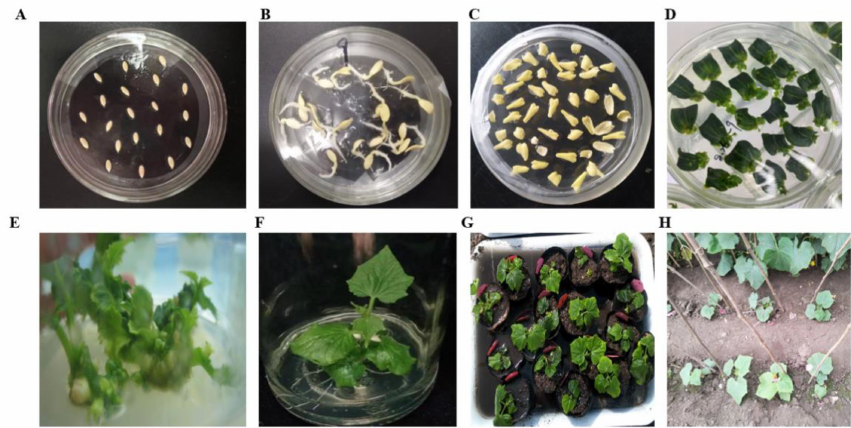
Figure 4. Genetic transformation of cucumber by CsGSH2 -p1250. ( A ) Seeds of M729. ( B ) Seed germination. ( C ) Agrobacterium-mediated infection of cotyledon nodes. ( D , E ) Differentiation culture. ( F ) Rooting culture. ( G ) Domestication culture. ( H ) Transplanting in the greenhouse.